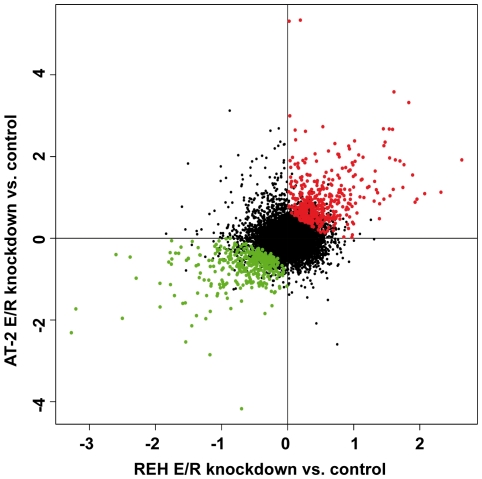
Scatter plot of differential gene expression values upon E/R KD in two cell lines.Each dot represents the mean regulation value (log2-fold change of E/R-repressed versus control cells) of three and two replicas, for REH and AT-2 cell lines, respectively. x-axis: REH cell line, y-axis: AT-2 cell line. Negative values indicate a decrease and positive values an increase in gene expression upon fusion gene KD. Green and red dots depict concordantly and significantly modulated genes in a joint analysis of both cell lines.